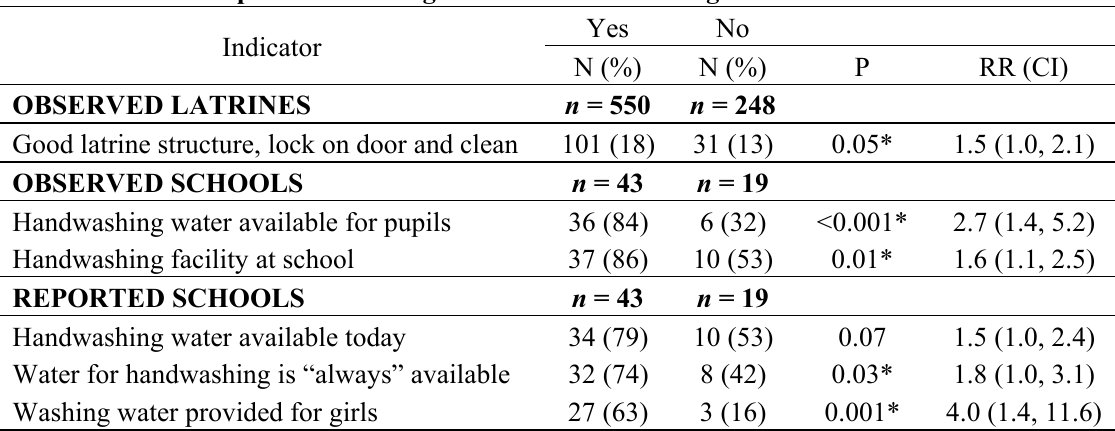
Table 2. Association between WASH conditions and whether water or handwashing interventions were received from NGO.